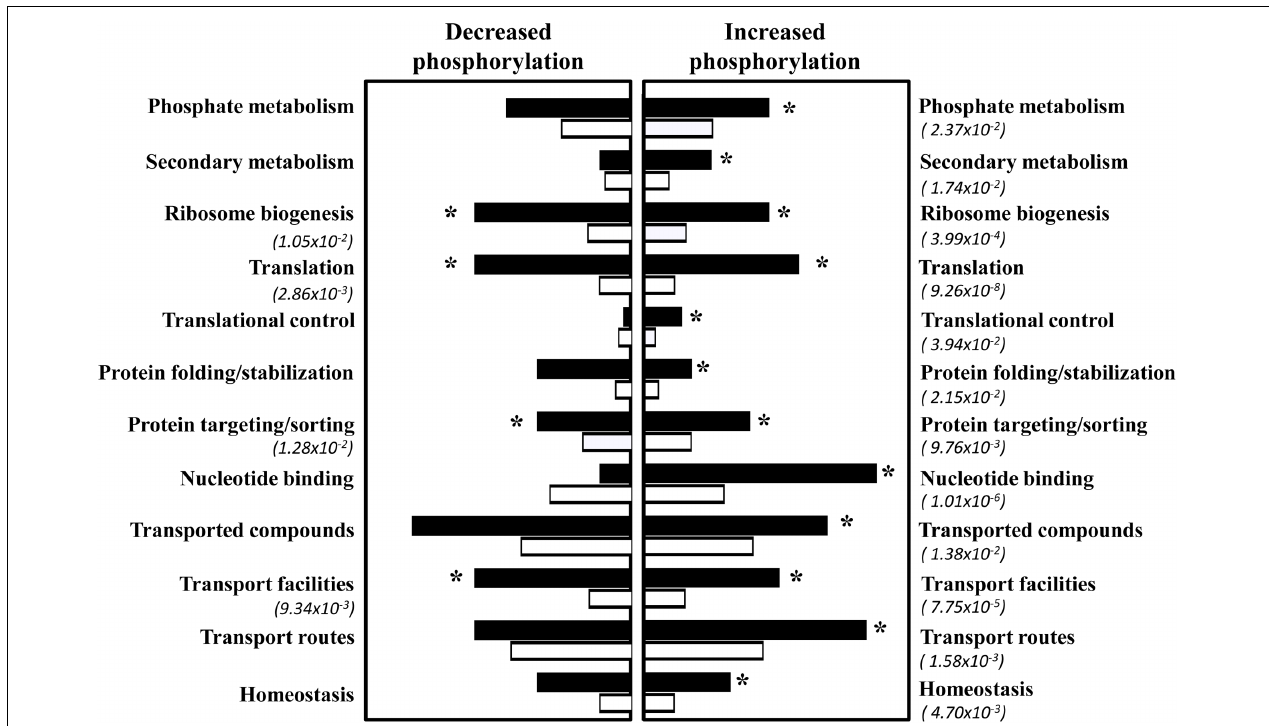
FIGURE 2 | Functional clustering of membrane-associated phosphoproteins that were found to change their phosphorylation degree in response to acetic acid. Phosphoproteins found to increase or decrease their phosphorylation degree (above twofold) in response to acetic acid were clustered according to their biological function according with the MIPS functional catalog. Functional classes considered to be enriched in the dataset (black bars), compared with the frequency of genes obtained when the whole yeast genome is used as an input (white bars), are indicated with